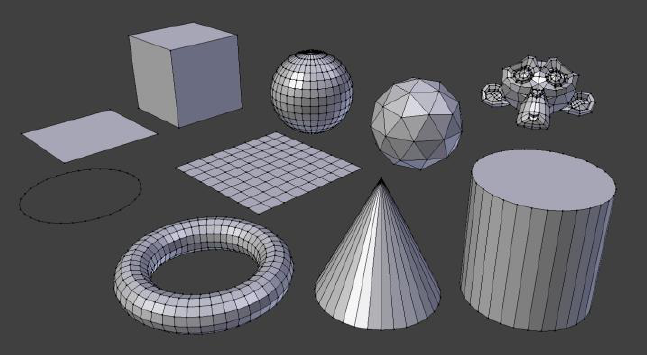
Figure 4. An example of objects rendered using flat 2D objects (triangles, quads).